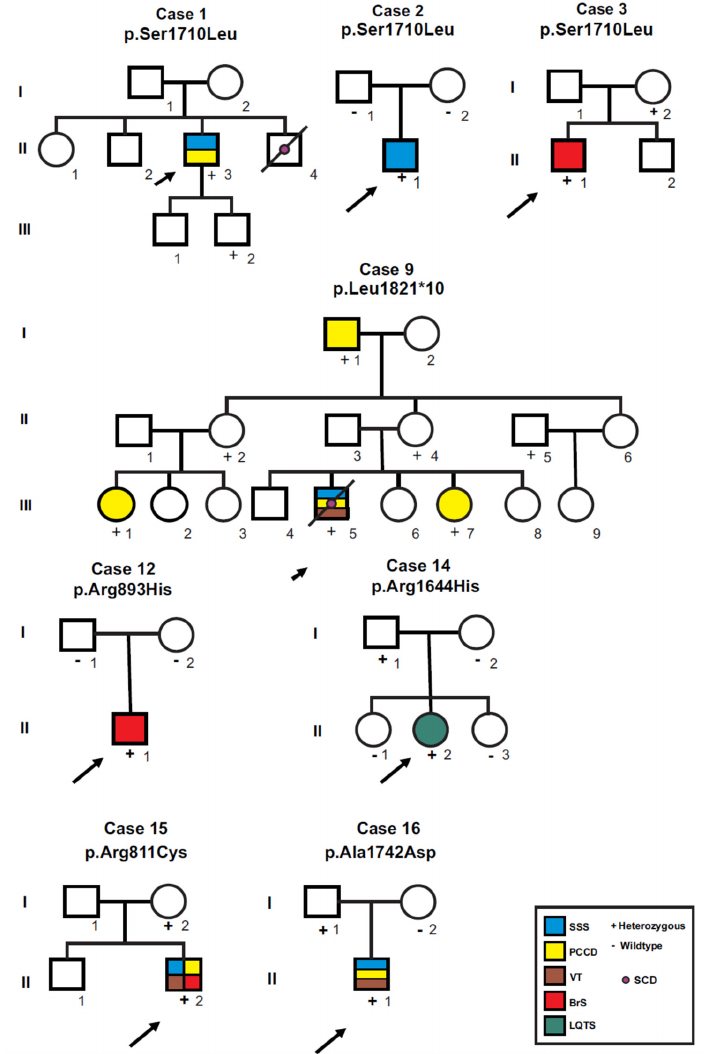
Figure 2. Pedigrees of probands heterozygous for SCN5A mutations where at least one first-degree relative was available for screening. Circles indicate females, squares, males; symbols with diagonal lines represent deceased individuals. Open symbols represent asymptomatic individuals, filled symbols were affected by arrhythmogenic syndromes according to the color code. Parentship was not confirmed by genetic analyses in any case. SSS: sick sinus syndrome; PCCD: progressive cardiac conduction disease; VT: ventricular tachycardia; BrS: Brugada syndrome; LQTS: long QT syndrome; SCD: sudden cardiac death.